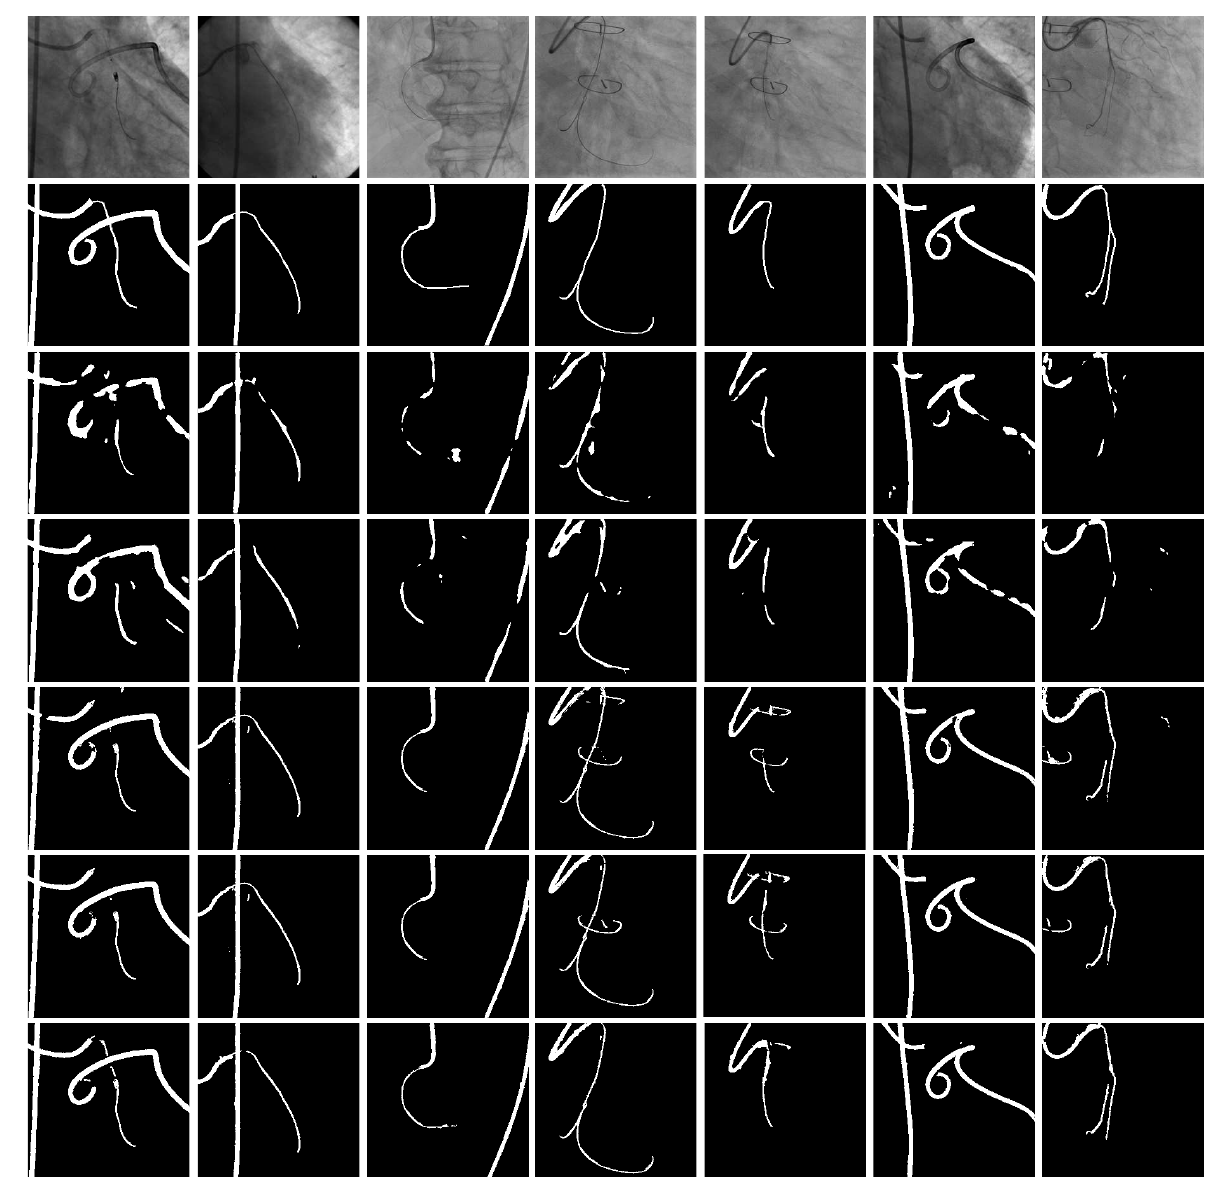
Figure 8. Test image results of a segmentation task using generated images. From top to bottom: input (1st row), the ground truth (2nd row), the baseline UNet [26] segmentation result (3rd row), augmented data segmentation result (4th row), the segmentation result of the model trained with the 5000 generated image (5th row), segmentation result of U-Net model trained with 30,000 genereated image (6th row), and the segmentation result of the model trained with 30,000 generated image plus 140 labeled image (7th